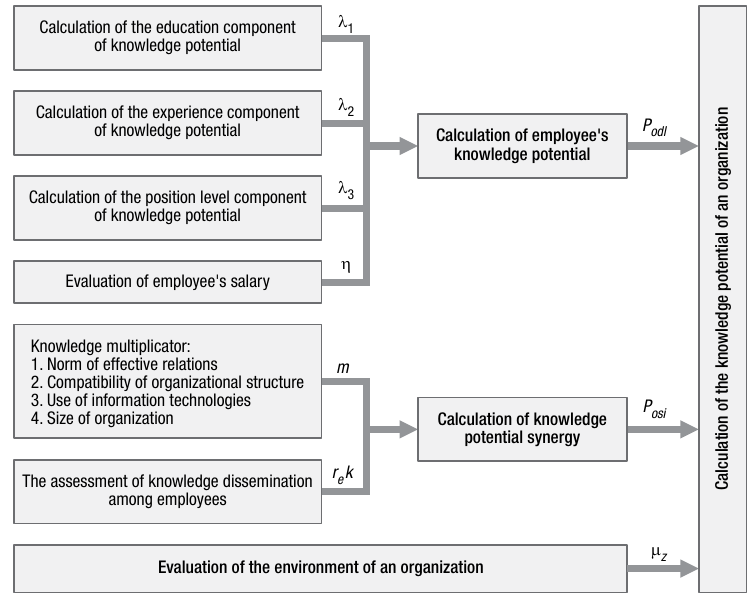
Fig. 1. Principle scheme of organization’s knowledge potential integrated